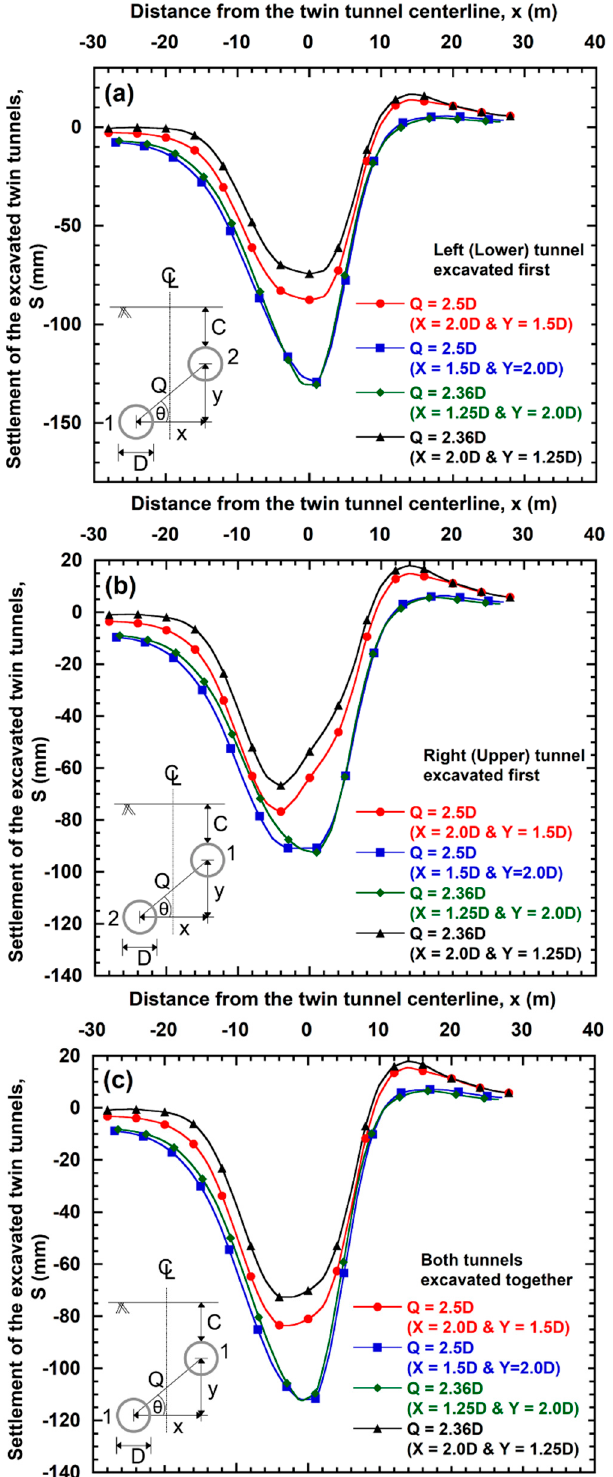
Figure 14. Effect of the horizontal and vertical spacing on the total surface settlement induced by offset arrangement twin tunnels at a fixed angular spacing ( a – c ).